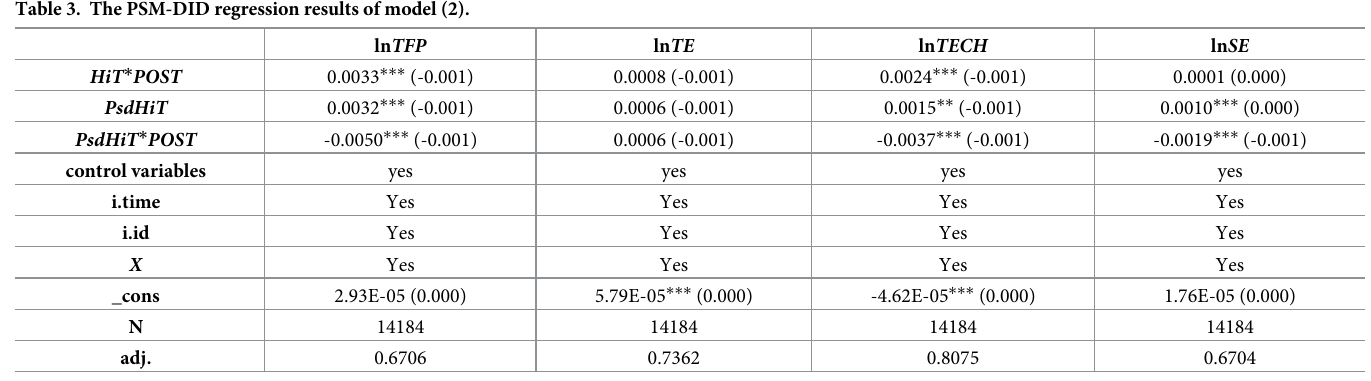
Table 3. The PSM-DID regression results of model (2).